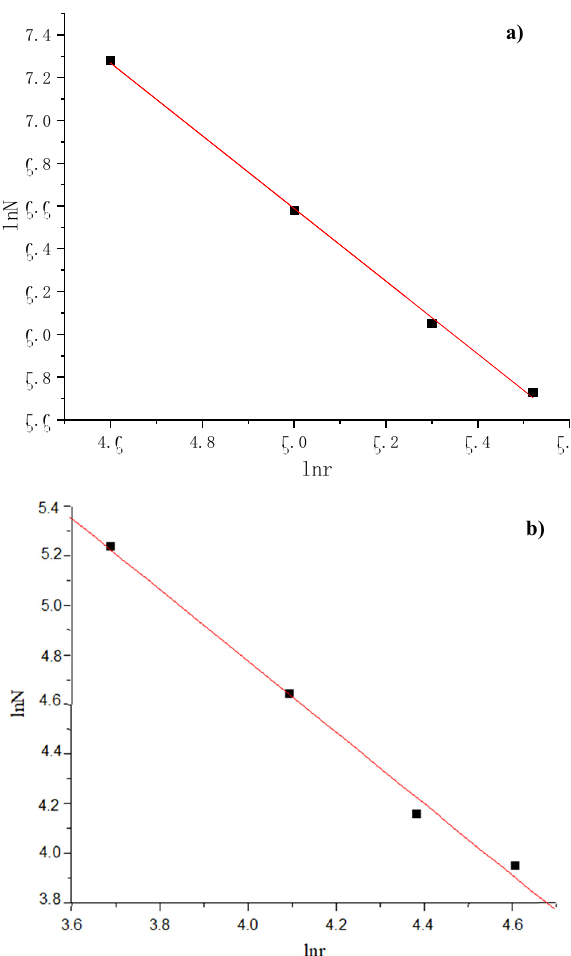
Figure 9: Double logarithmic fi tting of natural sand group ( a ) and Type I recycled sand group ( b )